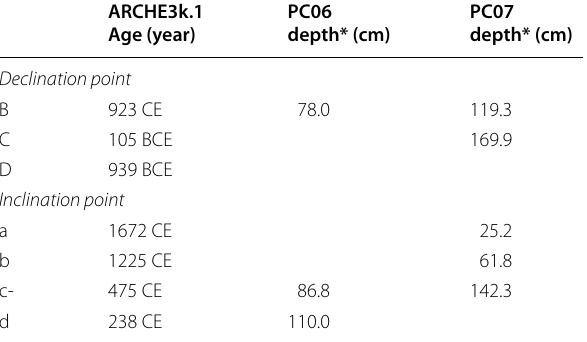
Table 1 Tie point between cores and ARCHE3k.1